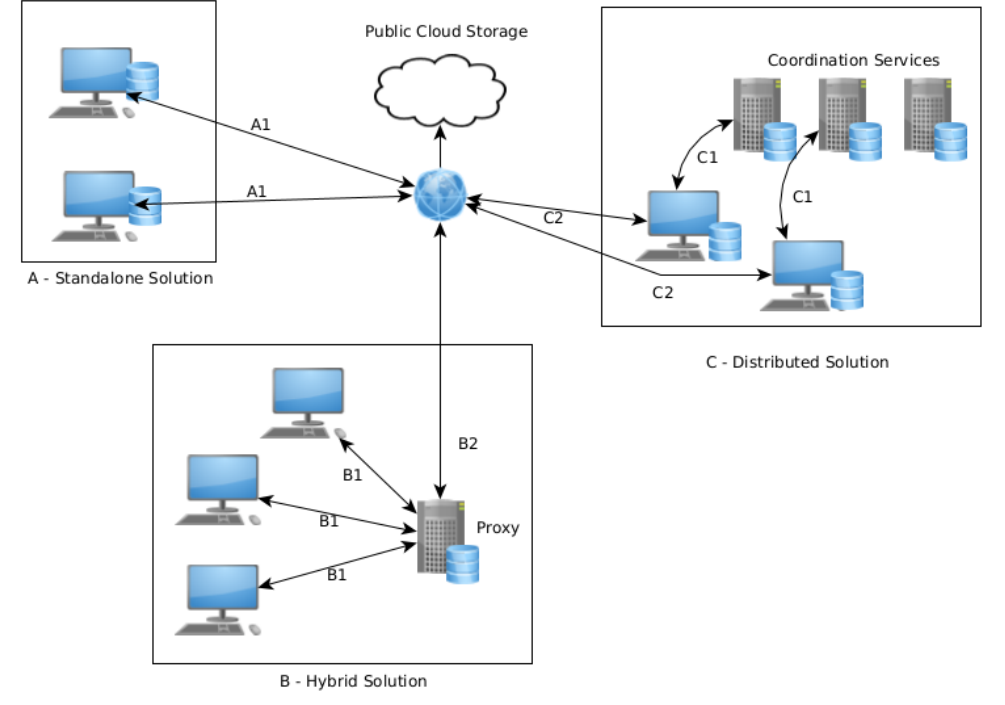
Figure 1. Different cloud